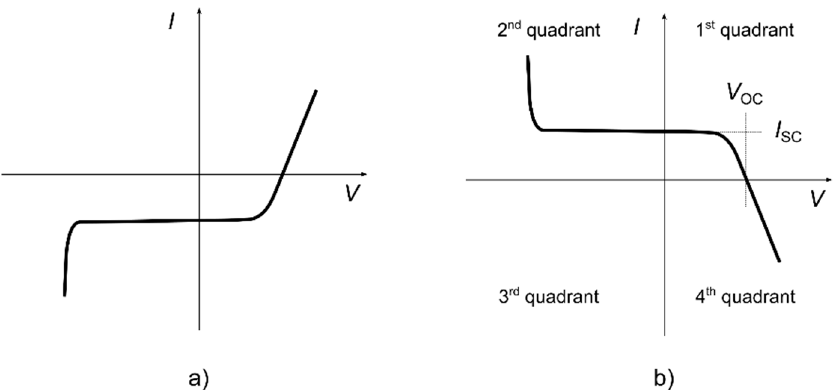
Figure 2. I-V curve of a photovoltaic cell. ( a ) Maintaining the current and voltage criteria from the diode. ( b ) Inverting the current criterion from the diode. V OC : open circuit voltage; I SC : short circuit current.